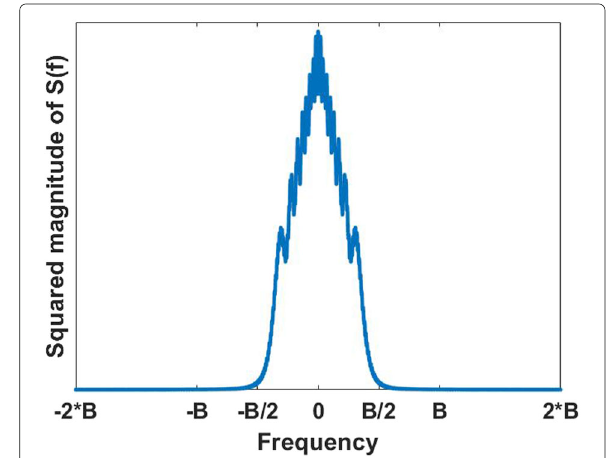
Fig. 3 Squared magnitude of fast Fourier transform which is proportional to PSD of the typical frequency function shown in Fig. 1. Edge frequencies have small PSD values and low frequencies have large PSD values. This agrees with SPP, as the edge frequencies have large derivatives and middle frequencies have large derivatives. In the end, we get a windowed PSD that should result in small AC